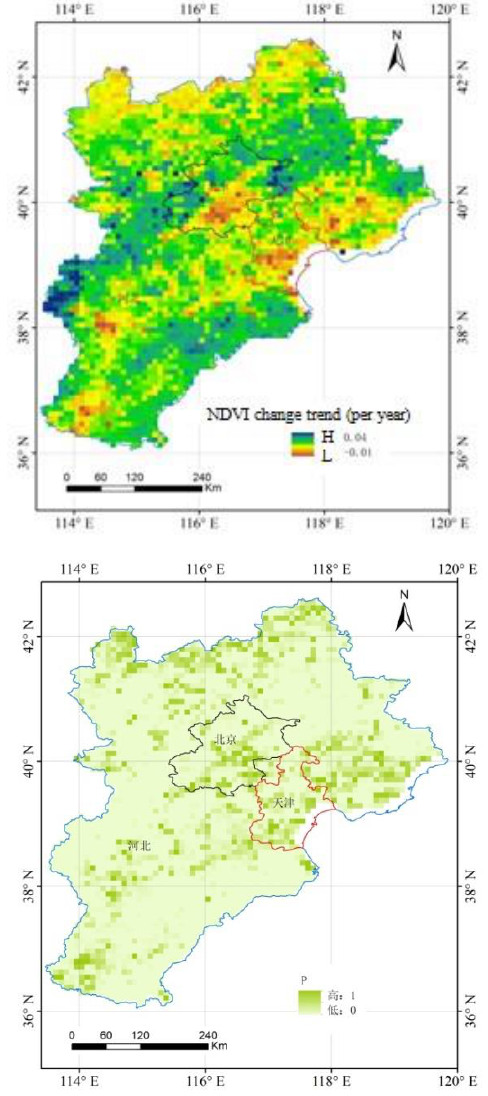
Figure 2 change slope of GIMMS NDVI (left) and significance level (right) of the vegetation growing season in the Beijing-Tianjin-Hebei region from 1982 to